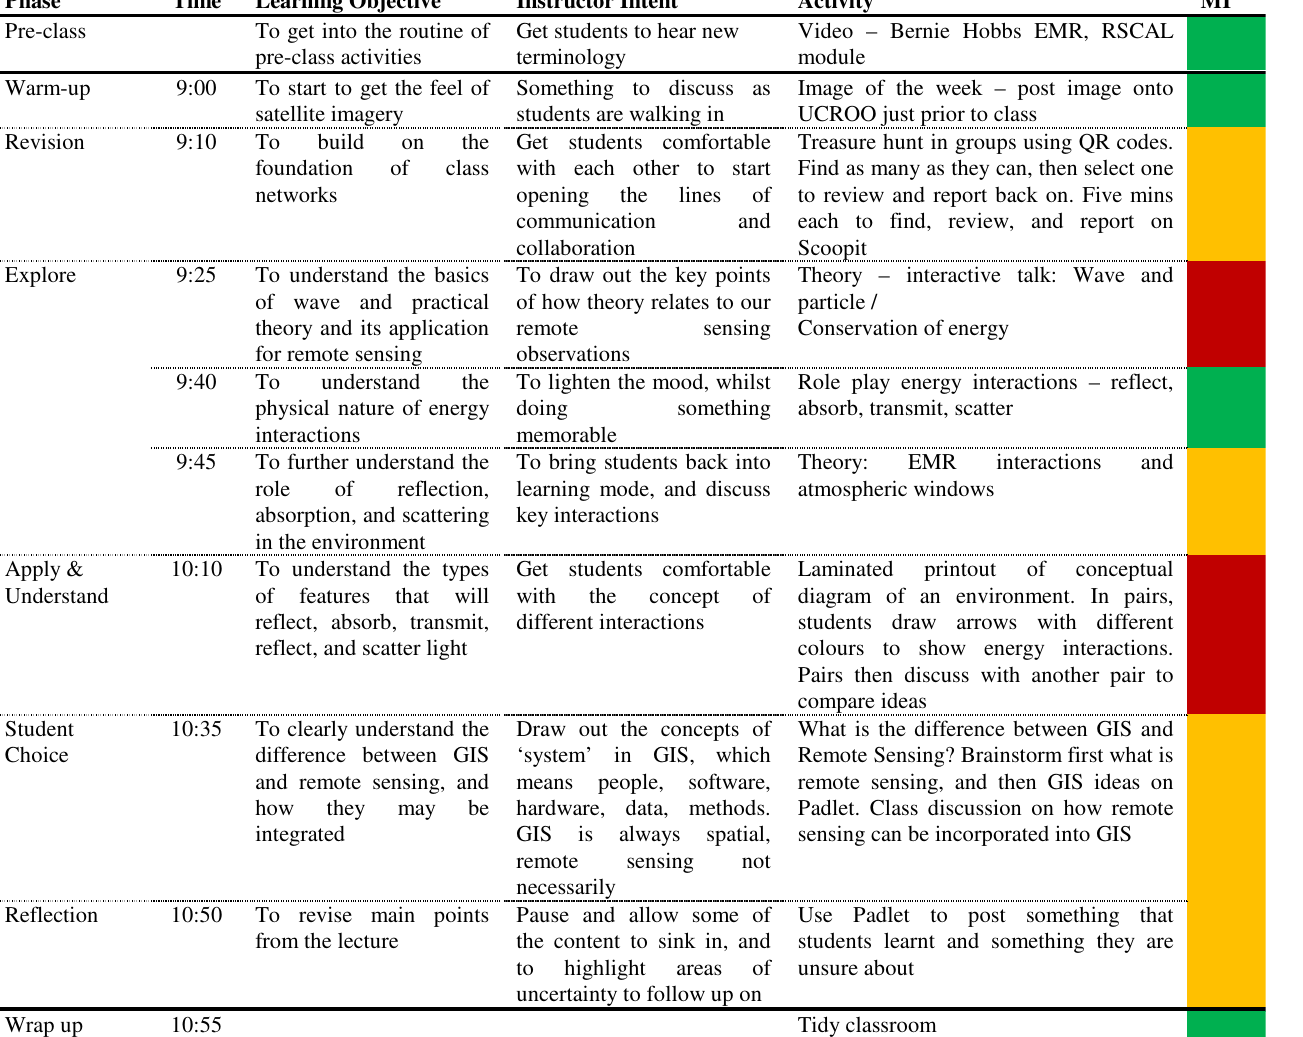
conceptual diagram of an environment. In pairs, students draw arrows with different colours to show energy